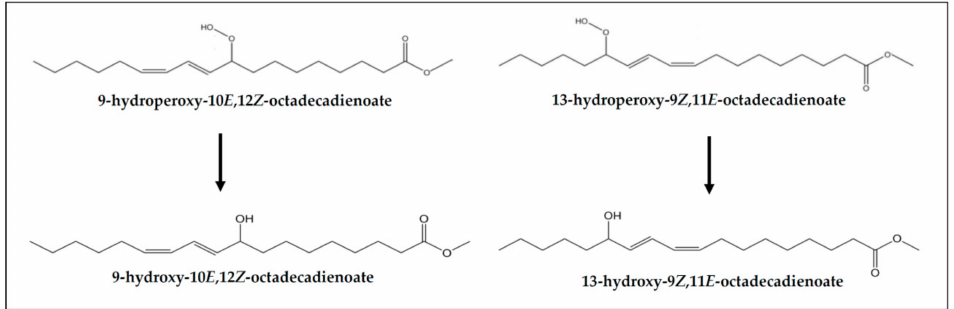
Figure 6. Monohydroxy-( Z , E )-conjugated dienes and their precursors monohydroperoxy-( Z , E )- conjugated dienes derived from 9 Z ,12 Z -octadecadienoate groups (linoleic acyl groups). (e) Concerning keto-conjugated dienes . As commented in Section 3.1, keto-( Z , E )- and -( E , E )-conjugated dienes are present in both undigested samples (VSX and RSX) and di- gestates (DVSX and DRSX), their concentration being higher in the latter than in the former, probably due to their generation from the respective monohydroperoxy-( Z , E )-